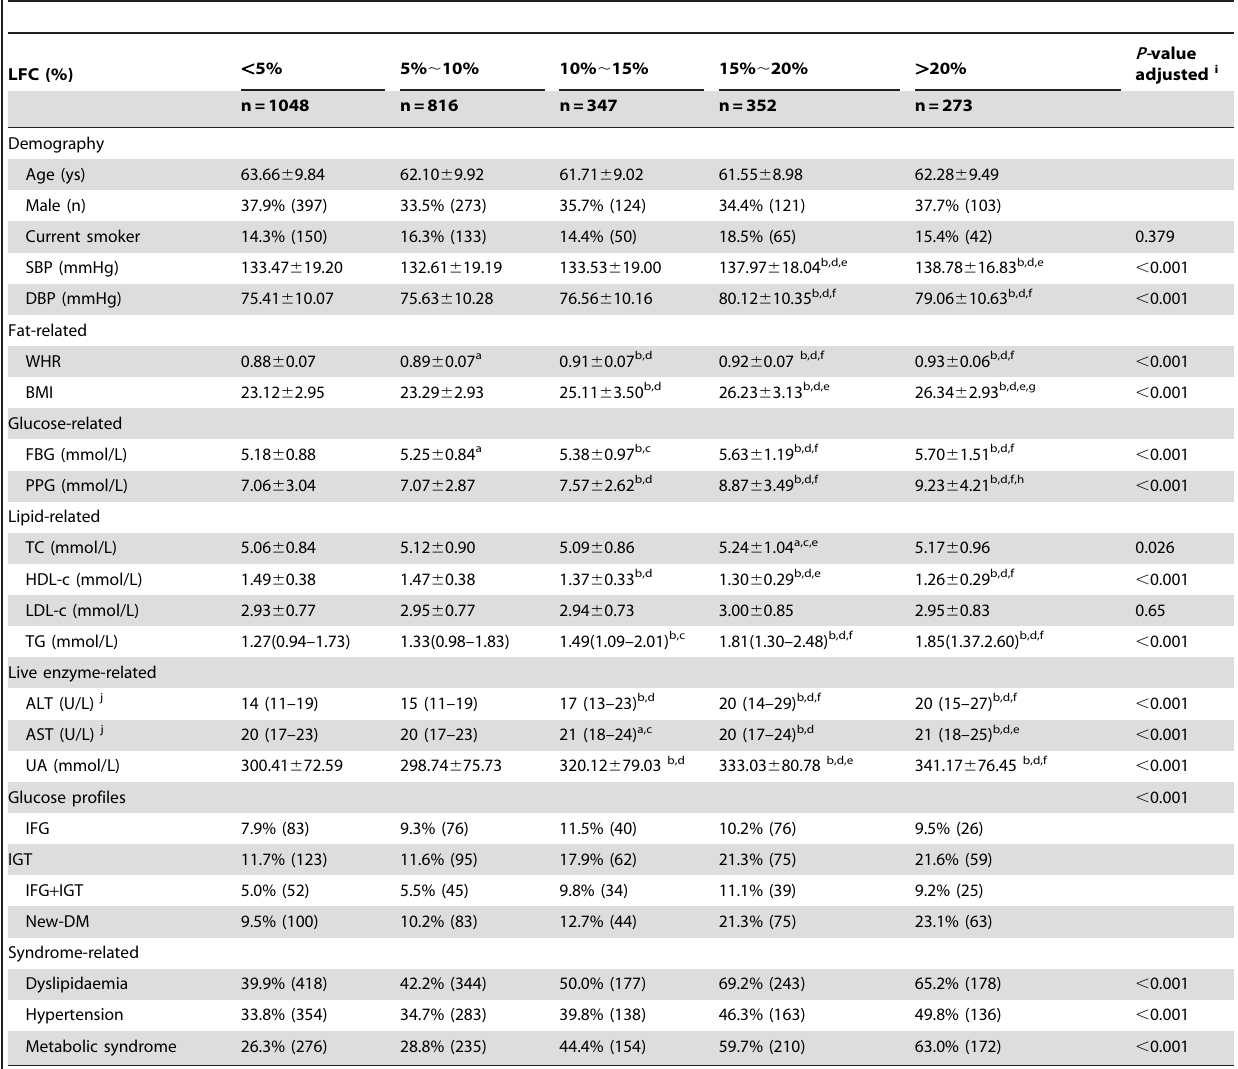
Table 1. Characteristics of the study participants stratified by the liver fat content.